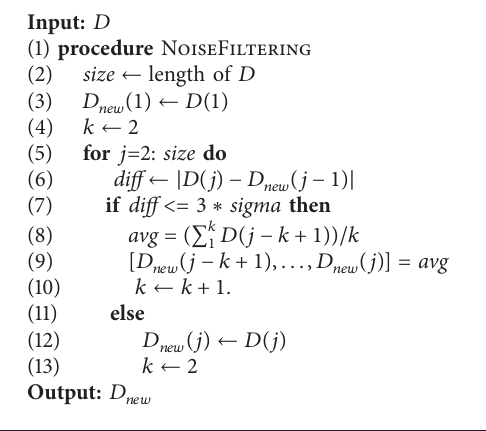
Figure 8: Customer demand data (without outliers).